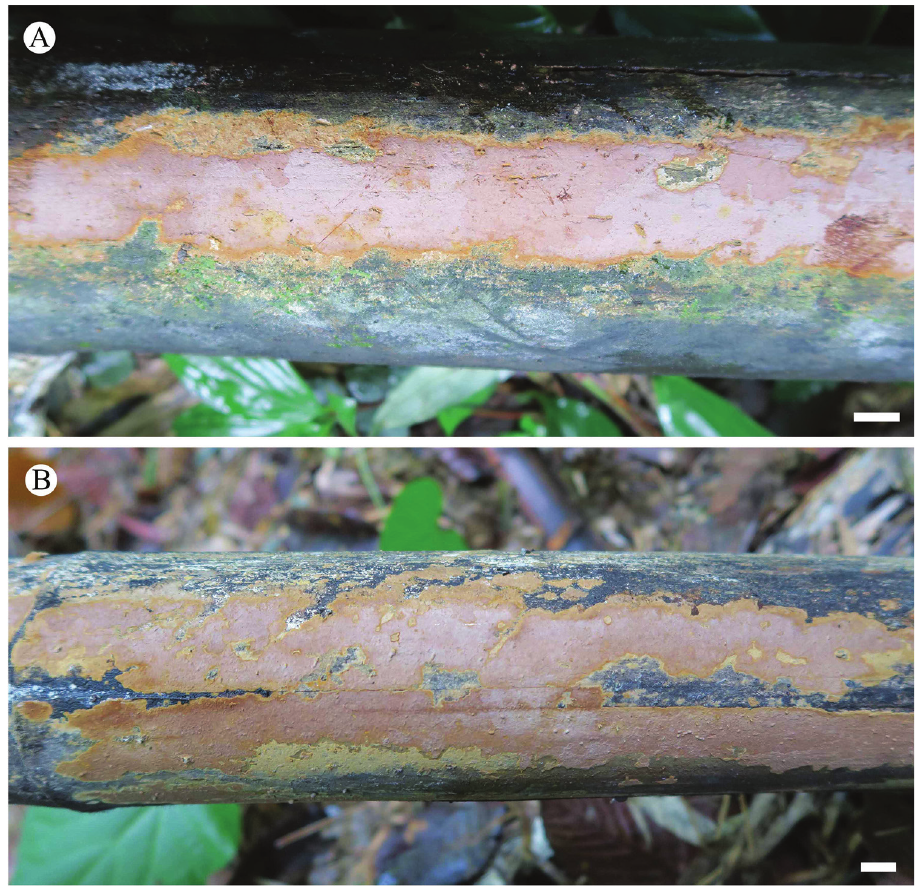
Figure 2. Basidiomes of Hymenochaete bambusicola . A He 4116 (holotype) B He 4121. Scale bars : 1 cm.